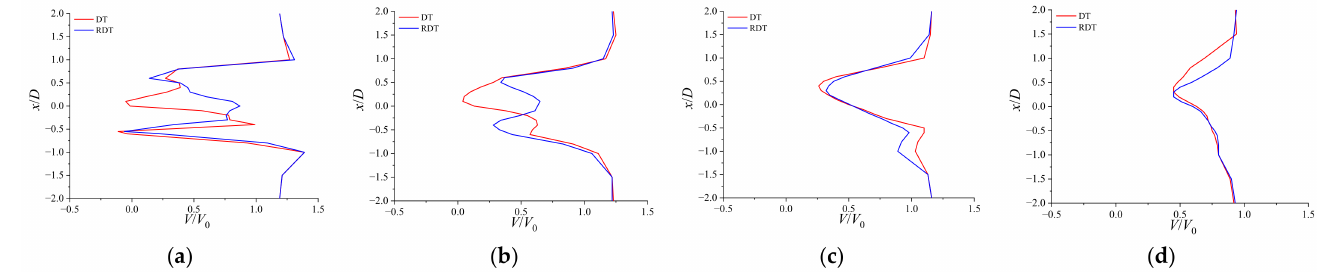
Figure 19. Profiles of mean streamwise velocity for γ = 20 ◦ at different streamwise locations in the central x - z plane: ( a ) z / D = 0.5; ( b ) z / D = 1.0; ( c ) z / D = 3.0; ( d ) z / D =